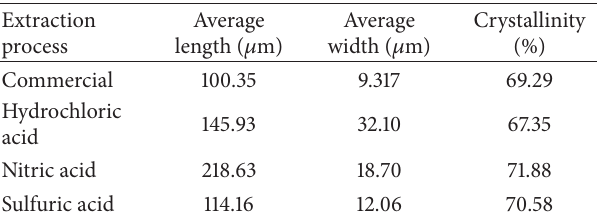
Table 1: Revealing cellulose particle sizes and percent crystallinity for cMCC and